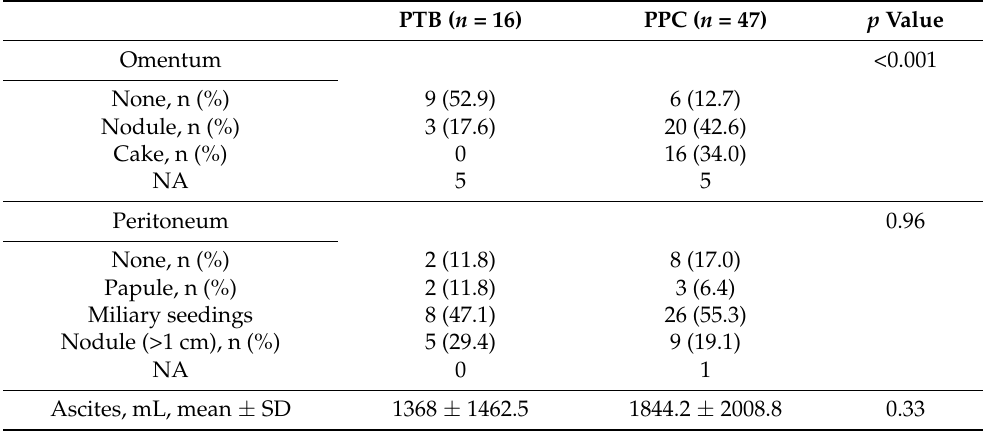
Table 3. Intraoperative